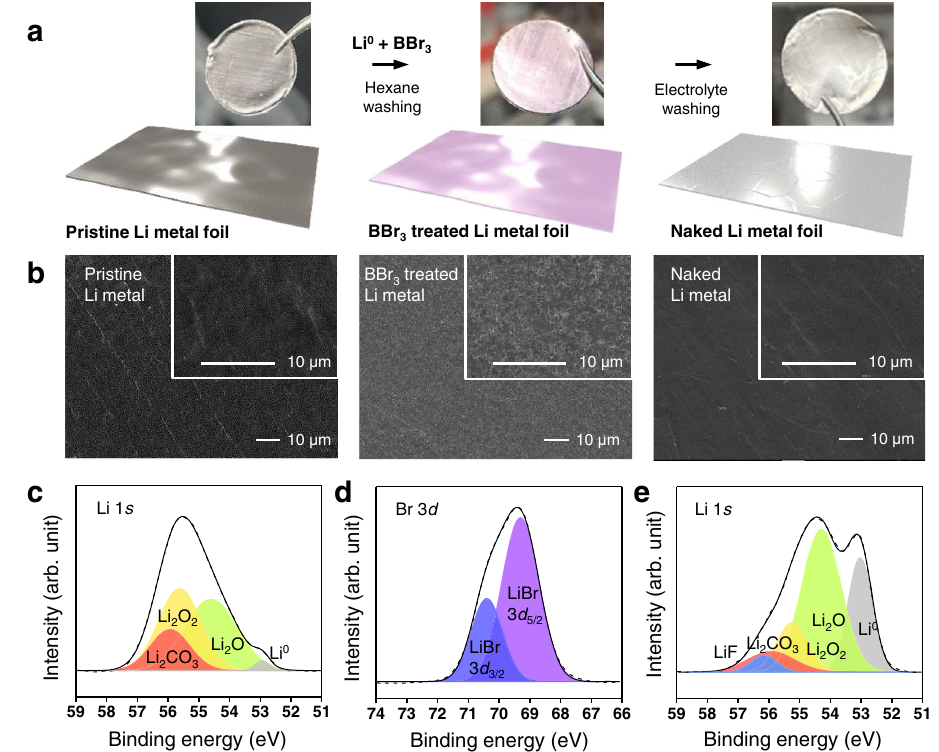
Fig. 2 | Characterization ofthe pristine,BBr 3 -treated, and nakedLi metal foils. a Schematic illustration of the elimination of the native fi lm with photographic images of theLimetalfoilsafterindividualreactionsteps: initspristine state(left), after treatment with BBr 3 (middle), after washing with the electrolyte of choice